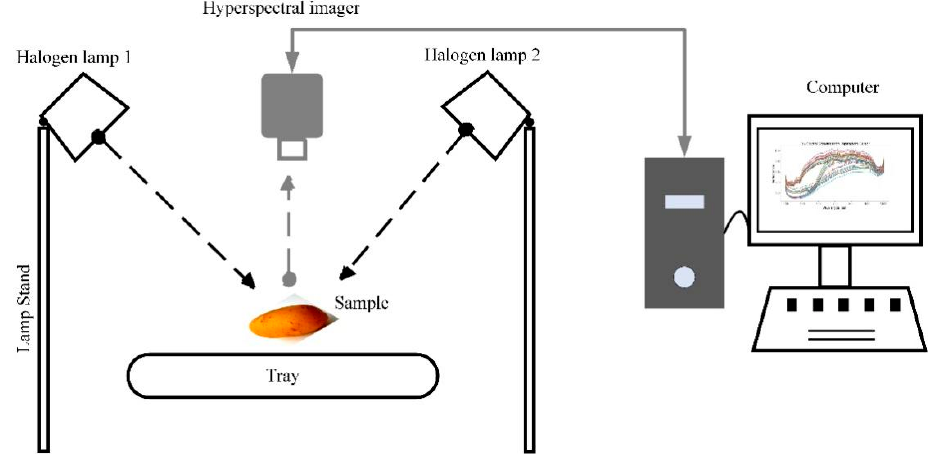
Figure 1. Hyperspectral imaging system in the laboratory.